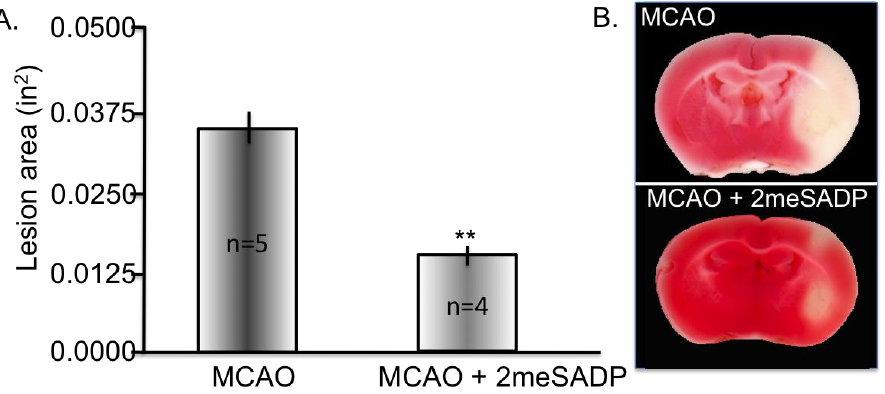
Figure 4. Purinergic receptor stimulation using 2-methylthioadenosine diphosphate trisodium salt (2meSADP) following middle cerebral artery occlusion (MCAO) rescues cortical cellular layers. Rats were treated with 100 μM 2meSADP 30 min post MCAO. Forty-eight hours following treatment the rats were sacrificed and triphenyltetrazolium chloride (TTC) staining was performed. ( A ) Histogram demonstrating the reduction in lesion volume with 2meSADP treatment. ( B ) Representative images from two different rats following MCAO with or without 2meSADP treatment. ** indicates p < 0.001 using student’s t